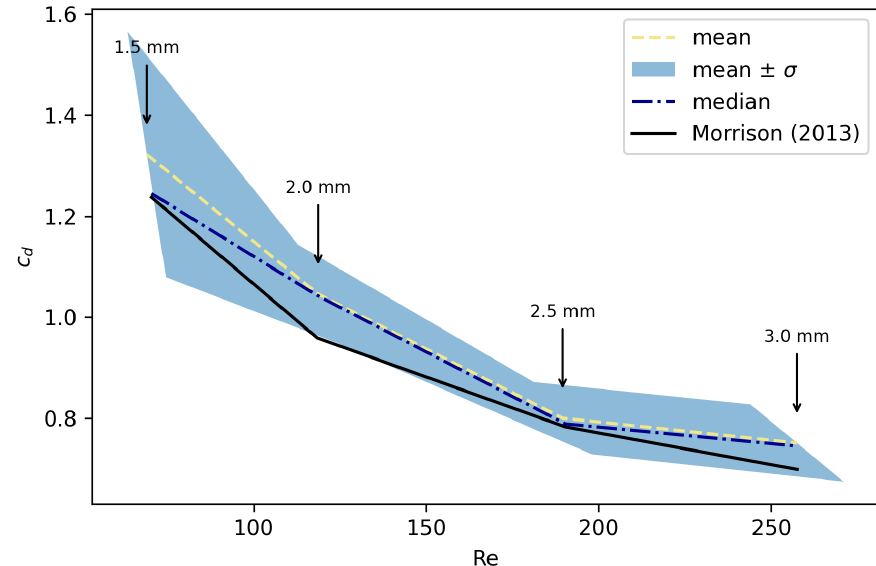
Figure 6. Correlation of drag coefficient and Reynolds number for particle group